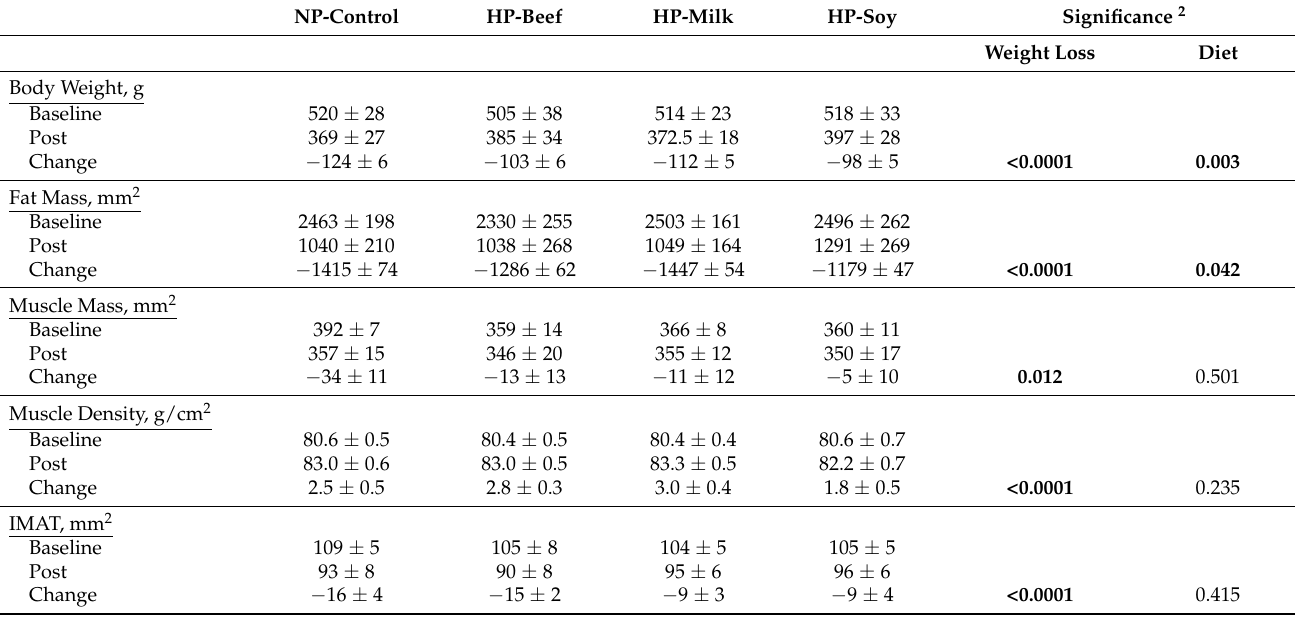
Figure 2. Changes in body weight over the 12-week weight loss intervention in a rat model of postmenopausal obesity. Energy restriction decreased body weight over the 12-week intervention, losing on average 109 ± 19 g or 26 ± 4% of baseline body weight. Table 3. Body Composition changes following 12 weeks of energy restriction in obese ovariectomized Sprague Dawley females 1 .